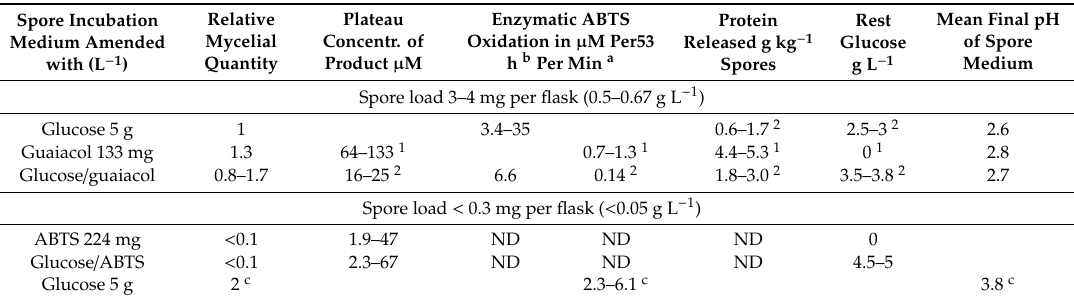
Table 6. Activity ranges of unwashed and aseptically germinating K. mutabilis basidiospores in 6 mL of high-purity solutions of glucose, guaiacol, and ABTS determined at 11 to 12 d ( n =